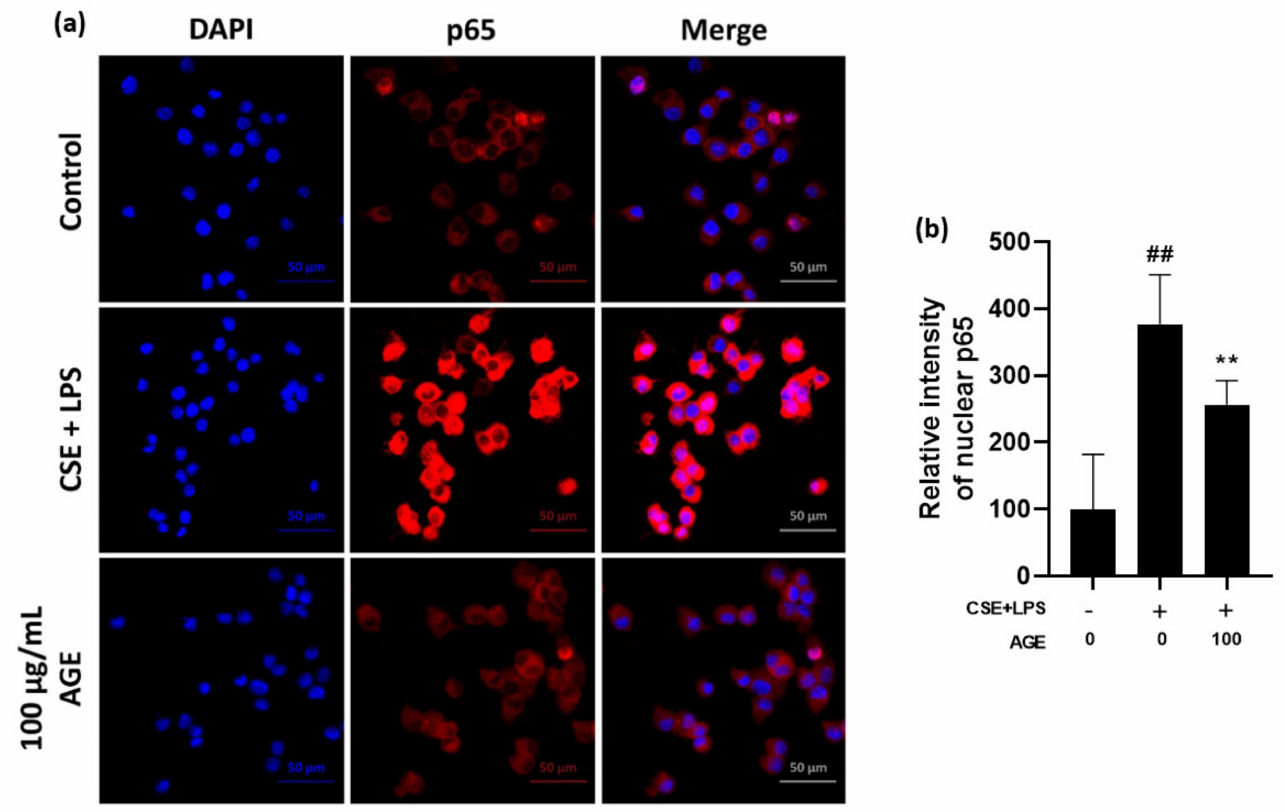
Figure 3. Effect of Artemisia gmelinii ethanol extract (AGE) on the activation of NF- κ B in MH-S macrophages. ( a ) MH-S macrophages were pre-treated with 25, 50, 100 µ g/mL of AGE for 2 h and were then treated with CSE (1%)/LPS (10 ng/mL) for 30 min. NF- κ B nuclear translocation was estimated using an anti-p65 antibody and an Alexa Fluor 488-conjugated anti-rabbit IgG antibody. The nuclei were stained with DAPI (scale bar: 50 µ m). The images show representative plots of three replicate experimens. ( b ) The relative p65 intensity in the nuclear region. Mean fluorescence intensity of each individual cell nucleus was measured using ImageJ software. The significant differences among the groups were analyzed using one-way analysis of variance by Bonferroni’s test ## p < 0.01 compared to the control group; ** p < 0.01 compared to the CSE + LPS-stimulated